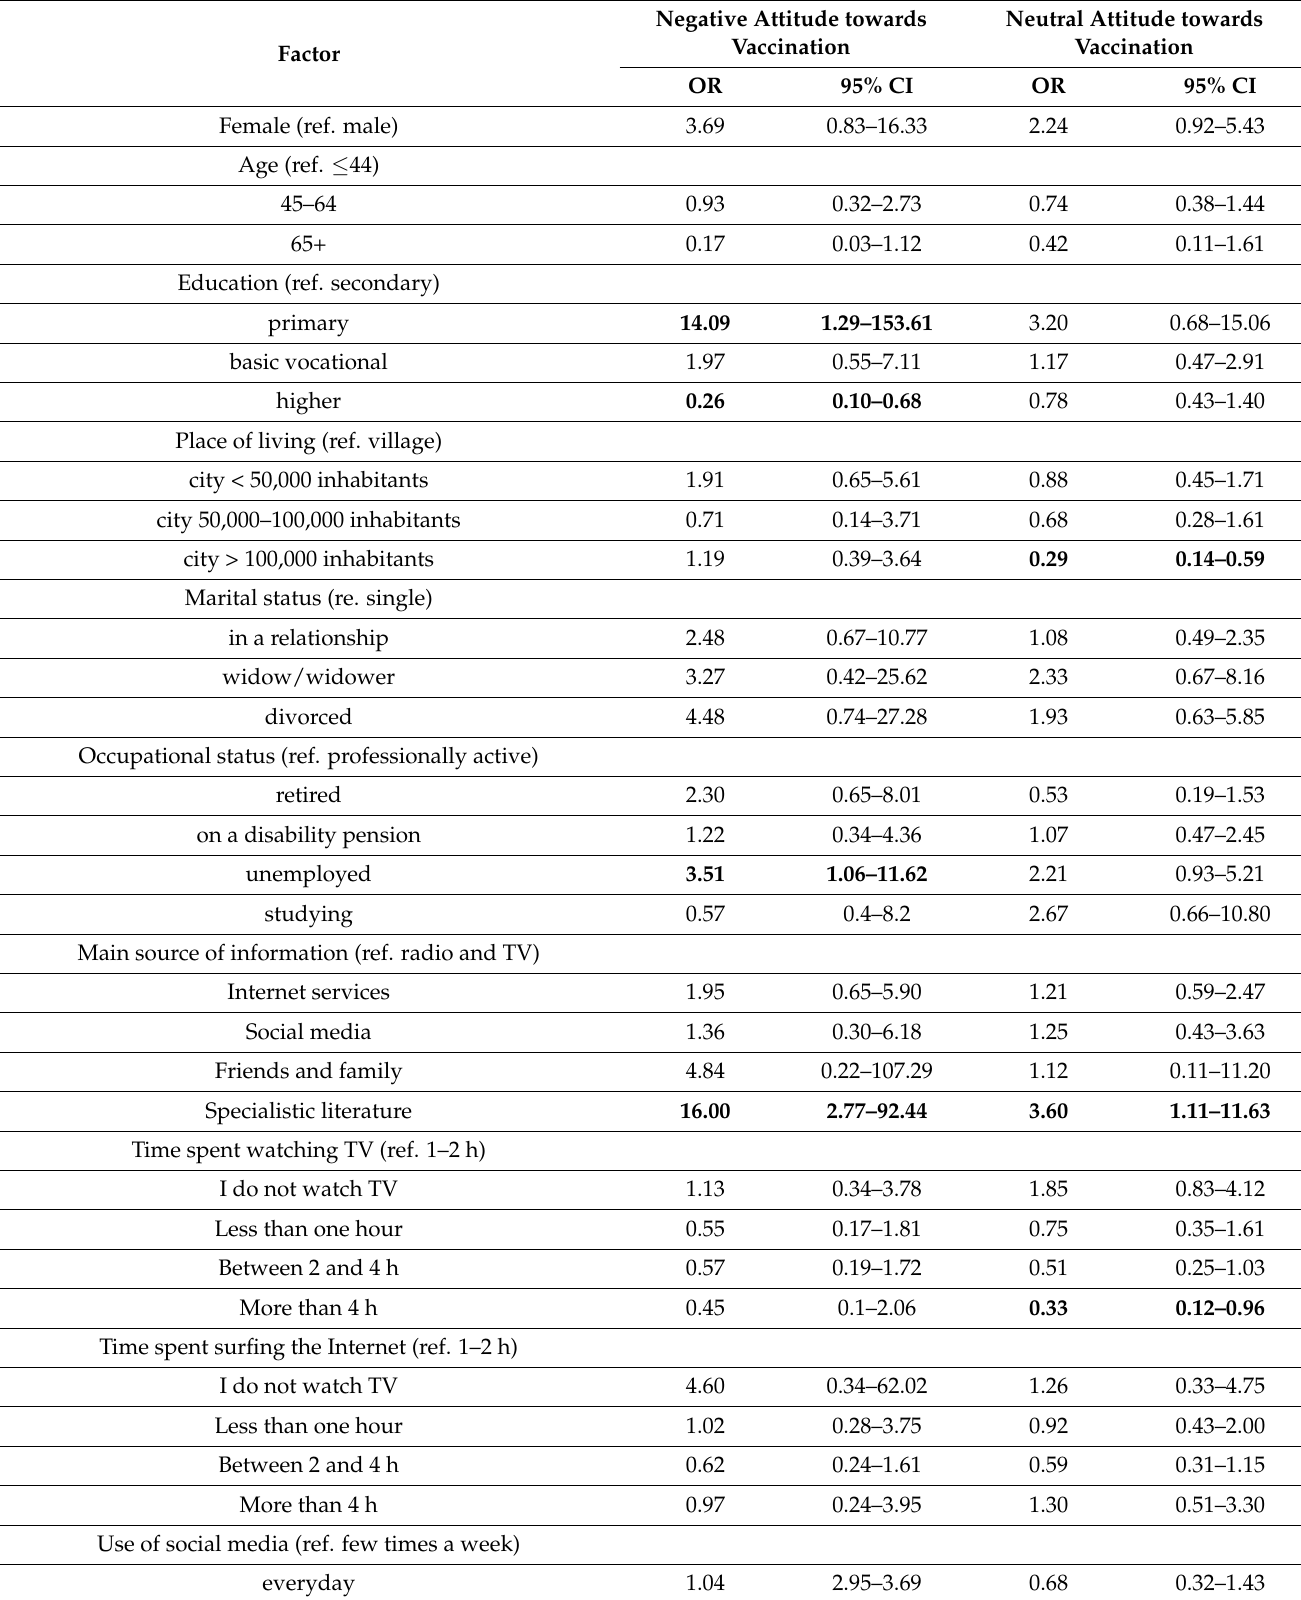
Table 3. Predictors of negative and neutral attitude towards vaccination using multivariable multinominal logistic regression. Significant factors are in